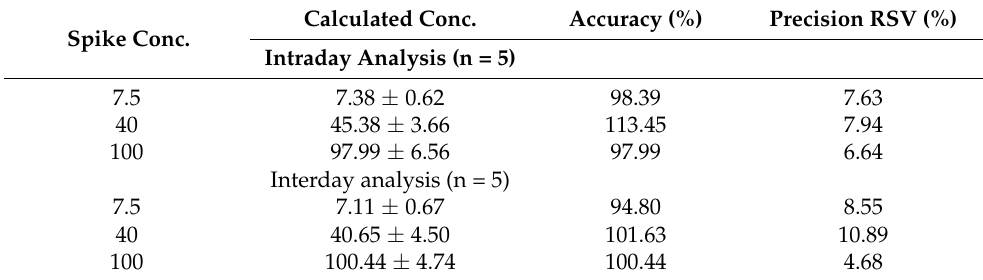
Table 2. Validation of interday and intraday analysis of the 5-MTHF spike in dialyzed plasma. Spike Conc.